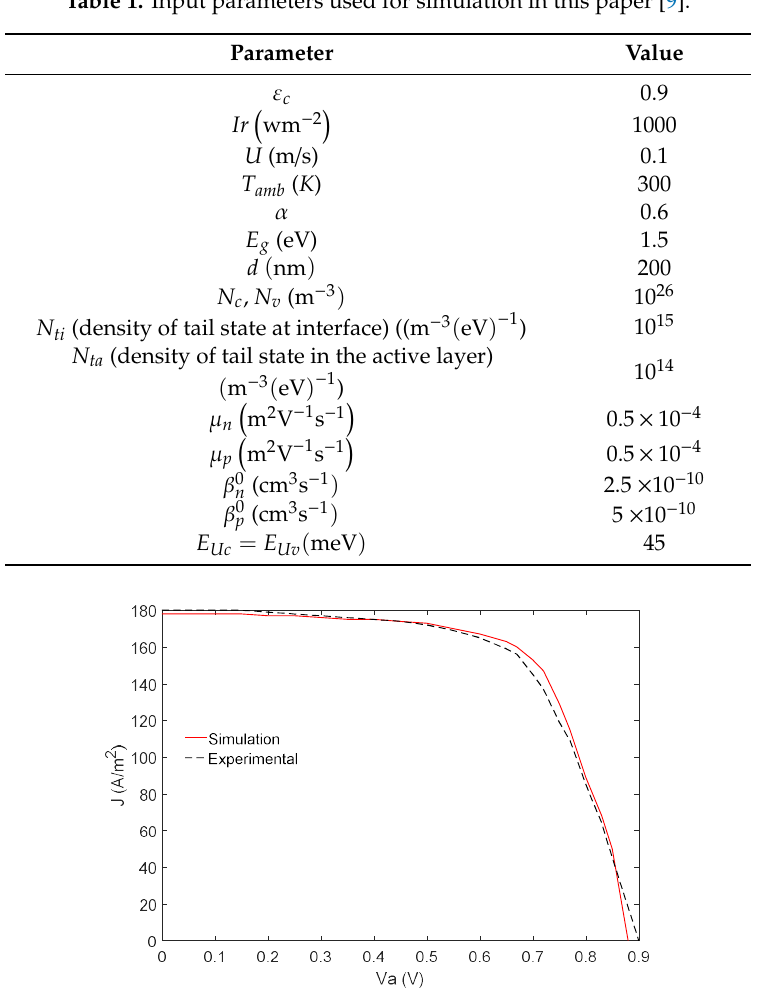
Table 1. Input parameters used for simulation in this paper [9].